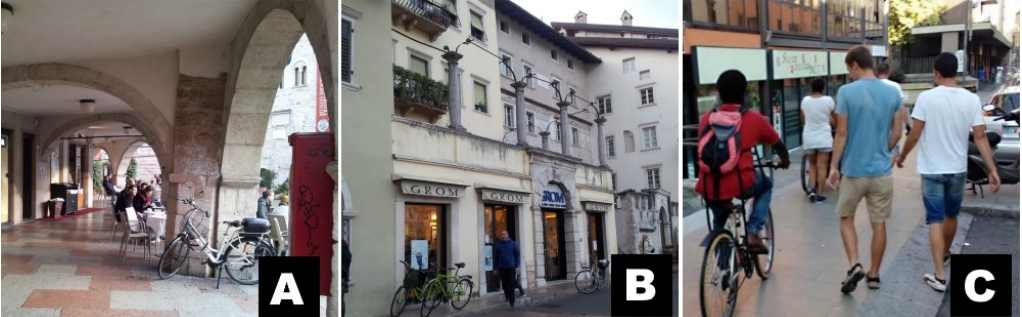
Photographs of pavements in the historical centre occupied by ( A ) the tables and chairs of a bar, ( B ) badly parked bicycles and ( C ) cyclists riding on the